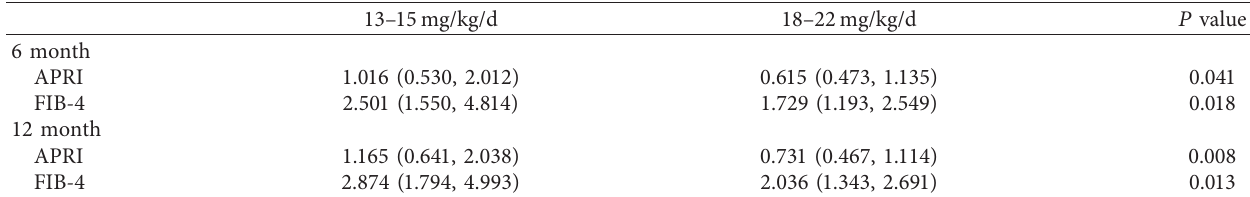
Table 5: Fibrosis risk score testing at the 6th and 12th month.